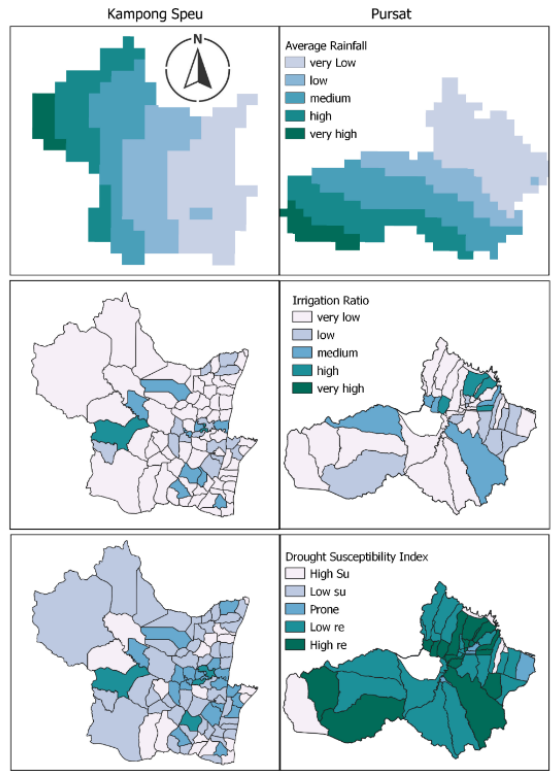
Table 3. Generic rice cropping calendar and possible drought occurrence.